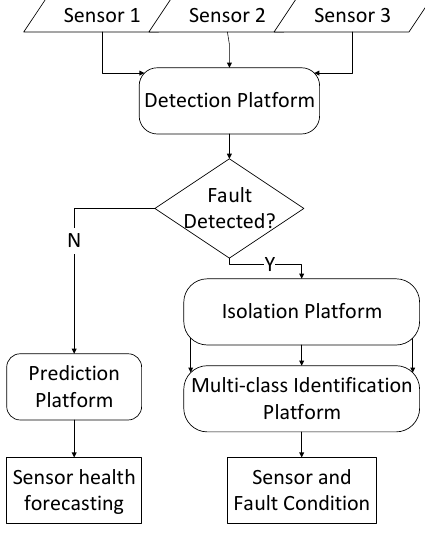
Figure 4. Proposed system